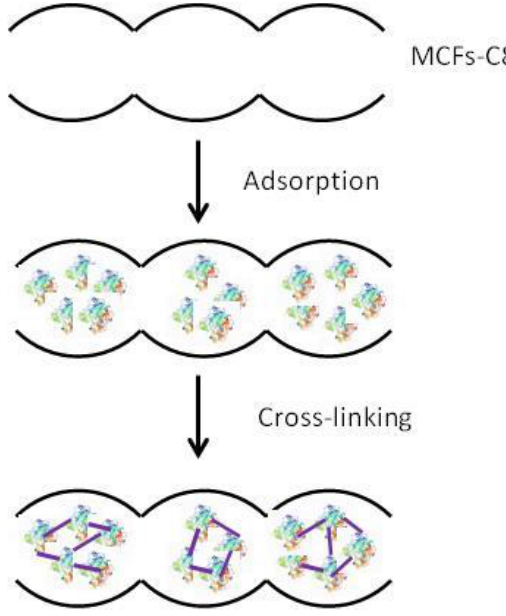
Figure 8. Lipase adsorption and cross-linking in MCF.